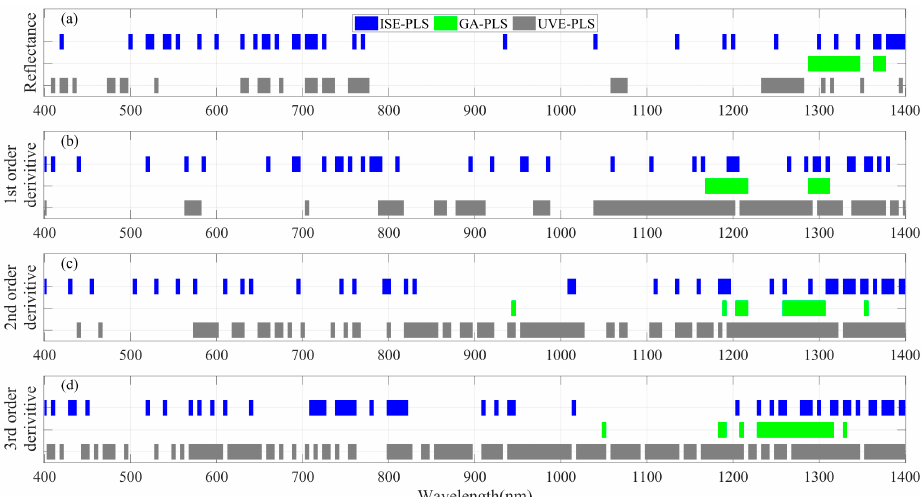
Figure 5. Distribution of bands selected with different band-selection methods for LNC estimation from spectra within 400–1400 nm. ( a ) Reflectance. ( b ) The 1st-order derivative spectra. ( c ) The 2nd-order derivative. ( d ) The 3rd-order derivative. The locations of the color blocks in the Wavelength-axis represent the bands involved in different PLS (blue for ISE-PLS, green for GA-PLS and grey for UVE-PLS) regression models.